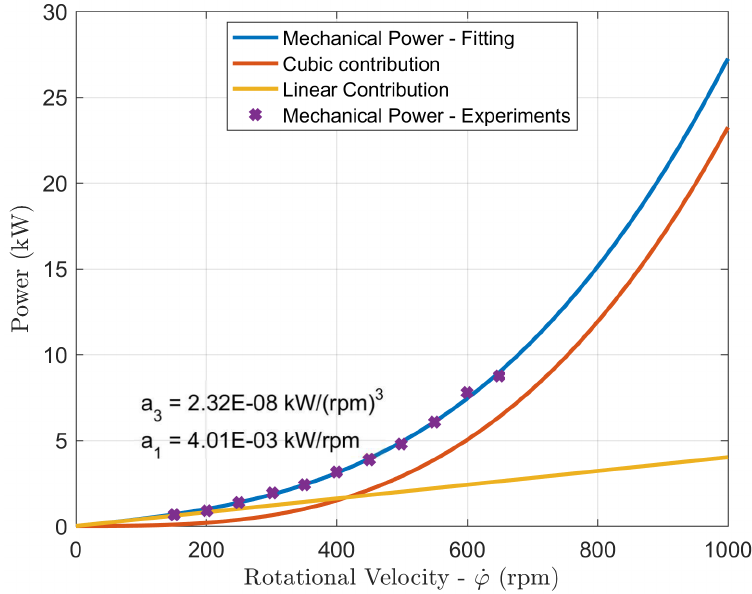
Figure 12. Experimental mechanical power at the flywheel motor shaft. Free